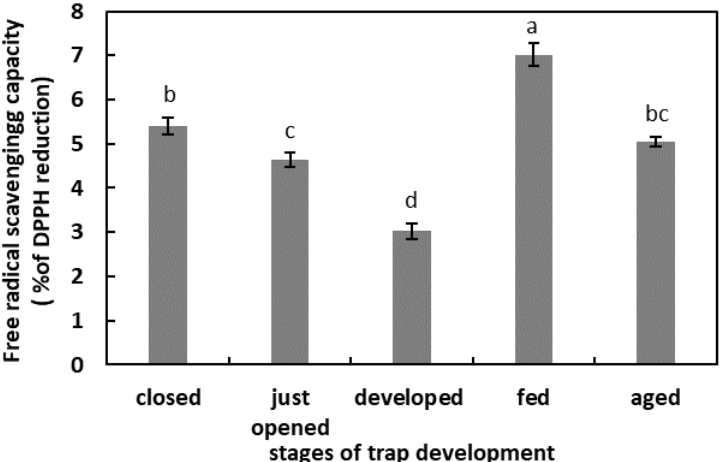
Figure 2. Total capacity of the free-radical reduction in digestive fluid in the traps at different developmental stages: closed, just opened, developed, fed (one day after feeding), and aged. Values are average ± SD of 3 repetitions. Letters ( a – d ) indicate homogenous groups determined after ANOVA and post hoc Fisher ’ s LSD test at p ≤ 0.05.